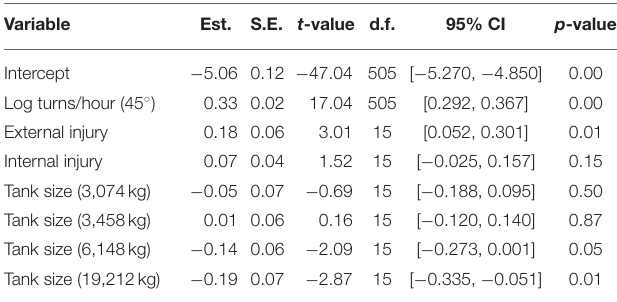
TABLE 2 | Linear mixed-effects model (LMEM) estimates of fixed effects, p -values and 95% confidence intervals for log-transformed VeDBA. Variable